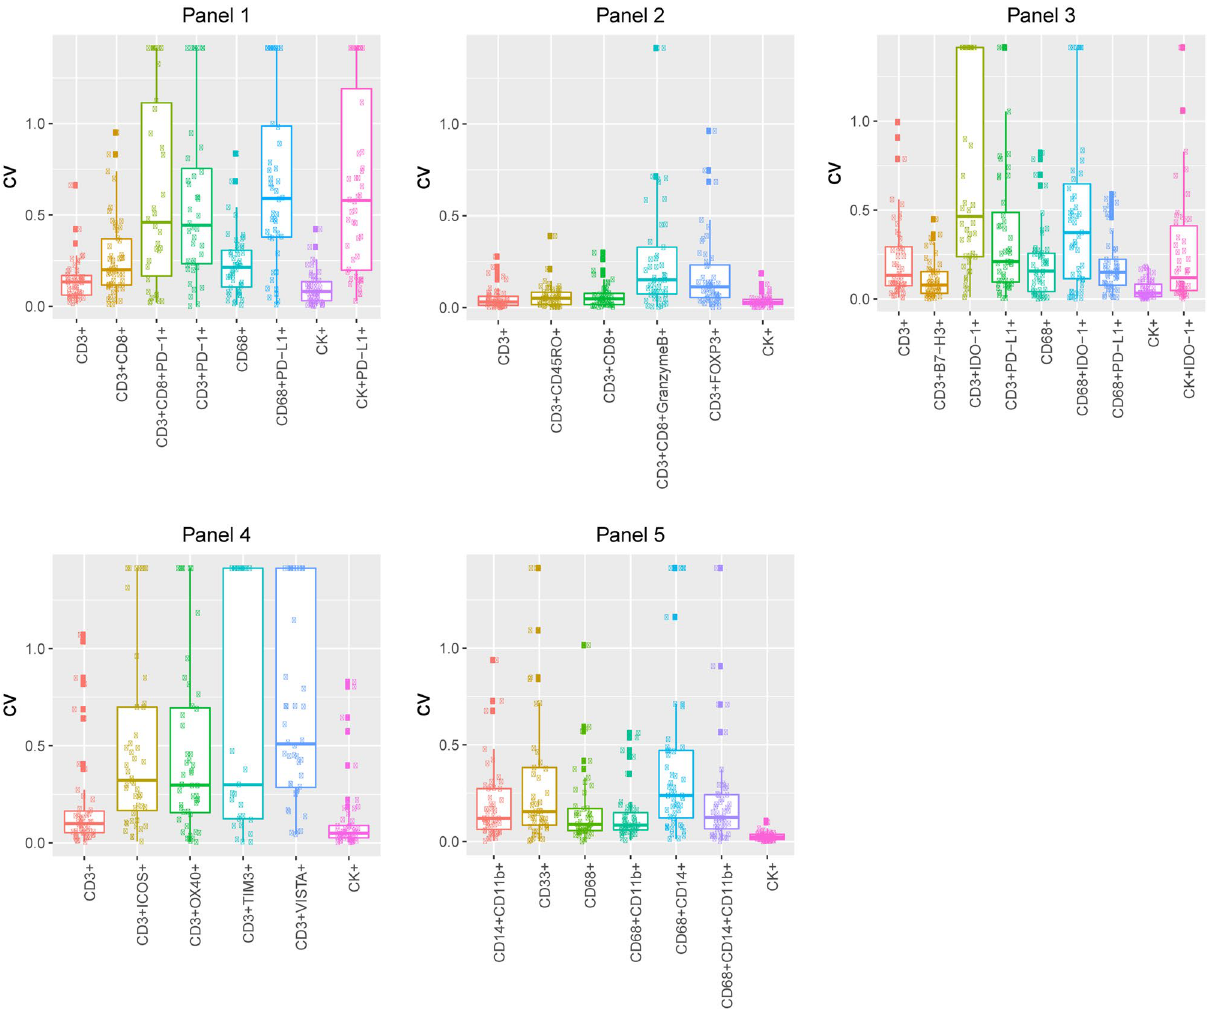
Figure 3. Coefficients of variation (CVs) for each panel. Boxplots show that the median value of the CV, within each region of each sample (at 2 weeks), is less than 0.5 for all the phenotypes studied in all panels. The images were generated using R studio software version